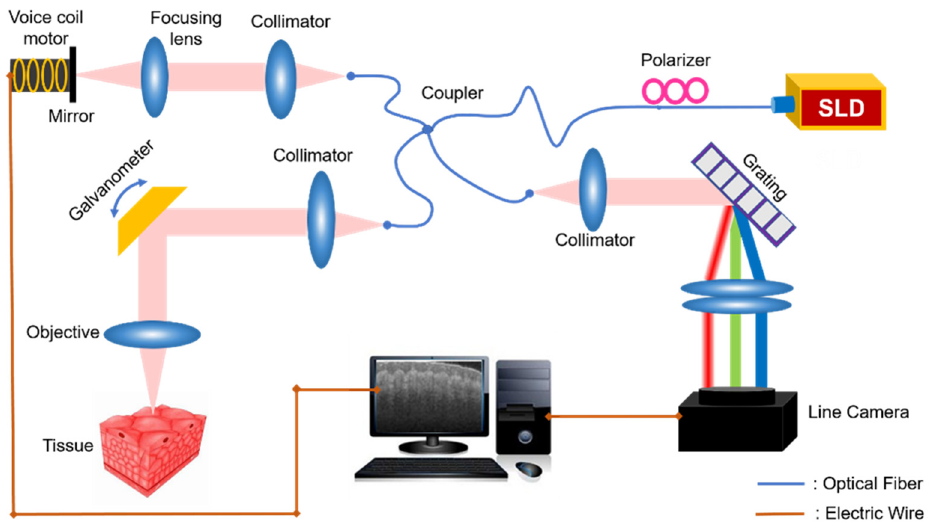
Figure 1. System schematic of the voice coil-based FROCT. Super luminescent diode (SLD) with a center wavelength of 1310 nm. Fiber coupler, fiber polarizer, collimator, focusing lens, galvanometer, imaging objective, reference mirror, voice coil meter and spectrometer. Spectrometer is composed of a reflection grating, a focusing lens and a line camera. The sample arm has the optical path to collect sample’s information, while the reference arm is of a moving mirror.